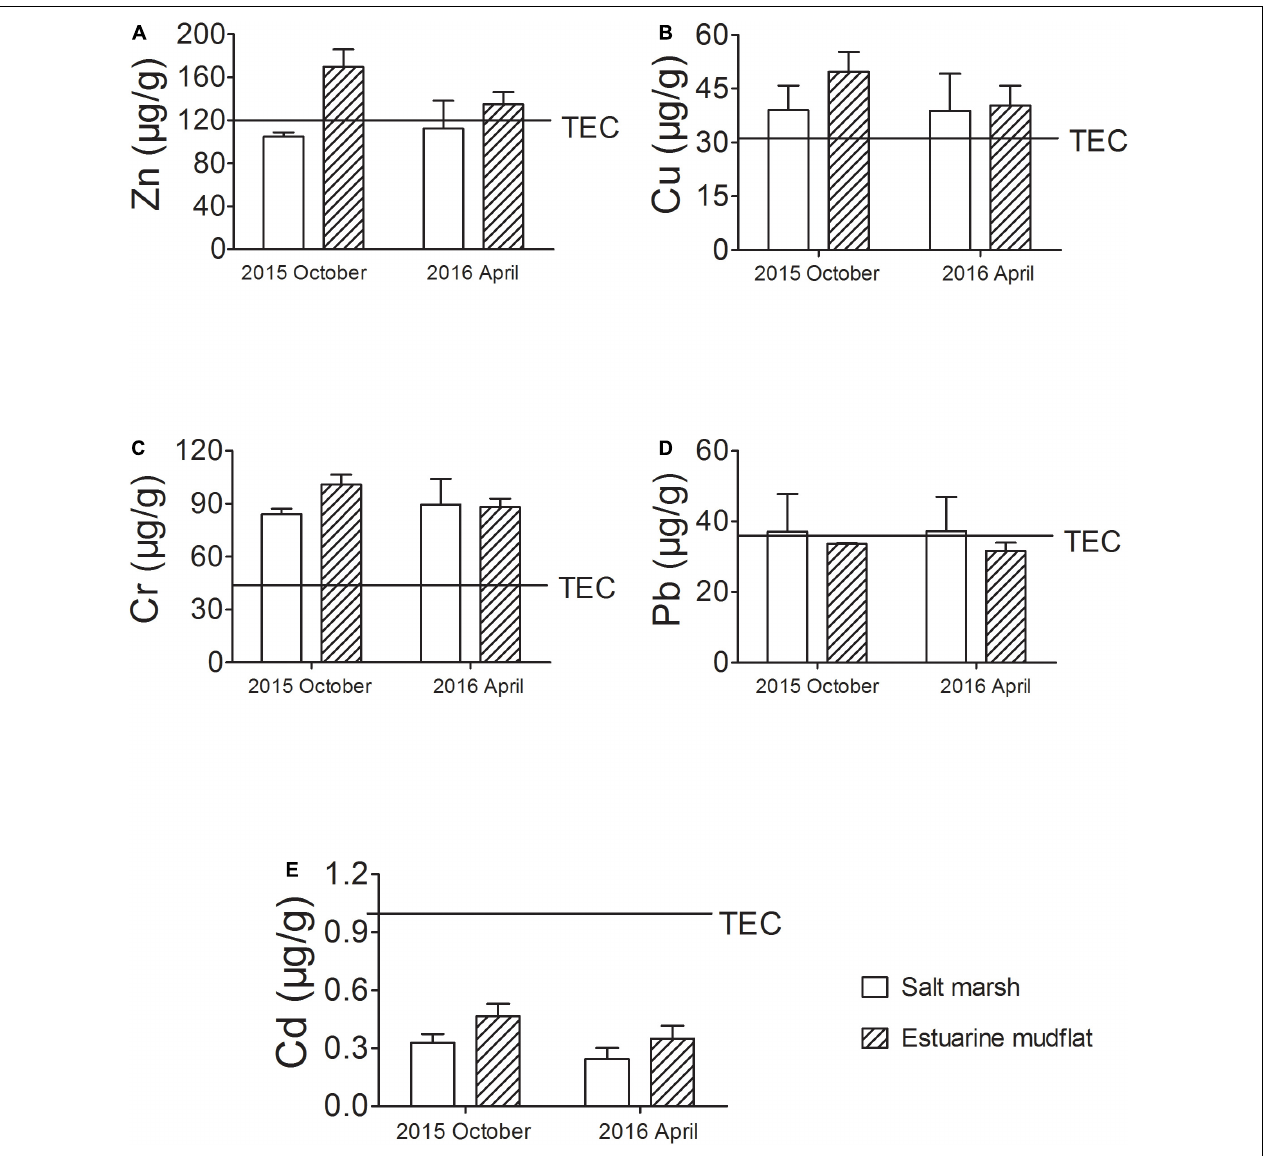
FIGURE 2 | Concentrations of heavy metals (A) Zn, (B) Cu, (C) Cr, (D) Pb, and (E) Cd in the intertidal sediments from estuarine mudflats (WSK, SDK, and LHK) and Chongming salt marshes (BBY and DWS) collected during October 2015 and April 2016 at the Yangtze River estuary. The threshold effect concentrations (TEC) of respective heavy metals are indicated (MacDonald et al.,